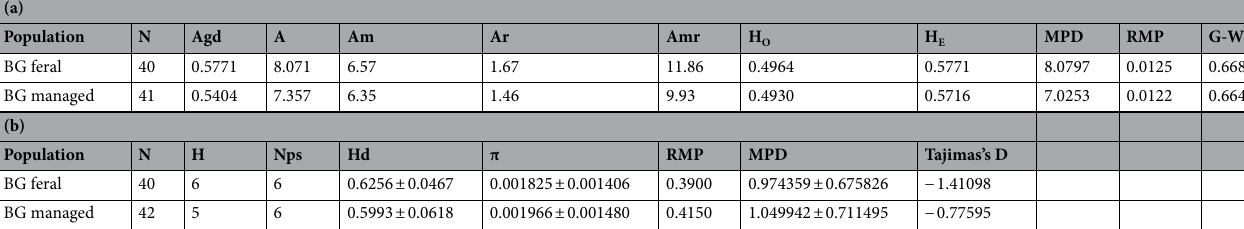
retained compared to one locus (A43) in MCs (Suppl. Table S3). For the expected homozygosity parameter (θ H ) half of the loci in one of the types of honey bee colonies analysed (feral vs managed) exhibited higher values com- pared to the other, while the θ from mean homozygosity was almost equal in both FCs and MCs from Belgrade (Suppl. Table S4a). The F IS parameter demonstrates that the Belgrade FCs exhibits higher values of inbreeding compared to the MCs (Suppl. Table S4b). The inbreeding coefficient ( F ) analysis showed that the F values are highly dependent on the estimator used for the analysis (Suppl. Table S5). According to the estimators with the highest correlation (TrioML/DyadML), FCs exhibits higher F values compared to MCs. In addition, the TrioML estimator exhibits the lowest variance for the FCs and the DyadML estimator shows the second-lowest variance for the same parameter. Statistically significant linkage disequilibrium was observed within 13 loci pairs in FCs and 10 loci pairs in MCs. Disequilibrium of the linkage for the pair A79/A7 was detected in both groups and in the MCs for the pair Ap249/B124 which are recognized as selectively adaptive loci 39 (Suppl. Table S6). Genetic diversity of mitochondrial tRNA leu -cox2 intergenic region sequences. Analysis of intergenic sequence variability of tRNA leu -cox2 revealed that a total of eight different haplotypes belonging to the eastern Mediterranean C lineage were present in Belgrade (Fig. 1 and Suppl. Table S1). Seven of the eight detected haplotypes have been previously described, while the haplotype defined by the transition at the position 3590 is novel and hereafter named C2dc according to the current nomenclature. This haplotype was detected only in the MCs. Interestingly, the haplotype C2db (first described by Tanasković et al. 40 , from North Serbia), was detected only in FCs. Sequences generated in this paper are deposited in GenBank, accession numbers ON187787-ON187868. Although both groups share a similar number of haplotypes, three were found only in FCs and two exclusively in MCs, while the most frequent haplotypes were found in both groups (Table 1, Suppl. Table S1, and Fig. 1). FCs exhibit somewhat higher values for the haplotype diversity parameter, while MCs exhibit higher values for the π and MPD parameters (Table 1). Higher π and MPD values suggest that the detected haplotypes in MCs are genealogically more distant than those in FCs, as can be seen in Fig. 1 and are also caused by the absence of the C2c haplotype in MCs. Interestingly, the RMP parameter is lower in FCs, further suggesting a higher diversity that can be found within this group.